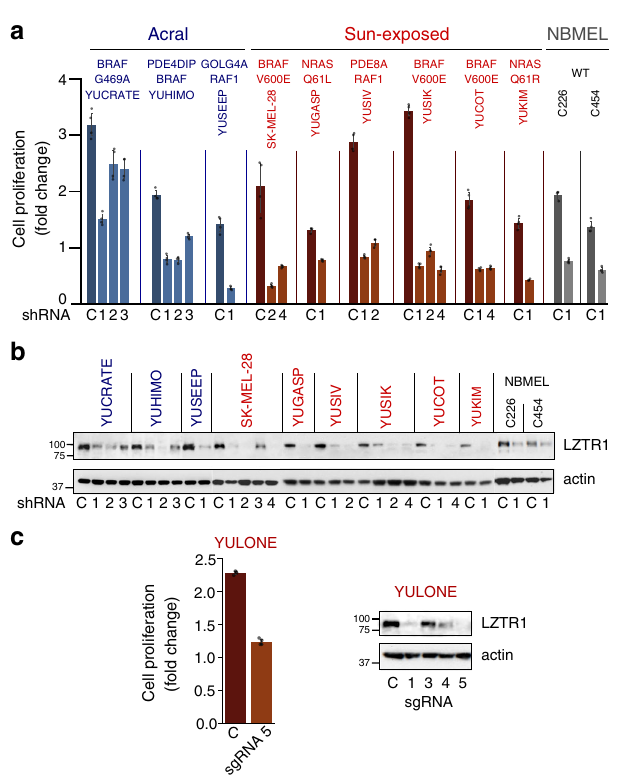
Fig. 3 Cell proliferation in response to the suppression of LZTR1. a Impact of LZTR1 knockdown on cell proliferation in nine primary melanoma cell lines and two normal human melanocyte lines (NBMEL). Key mutations are indicated (Supplementary Table 7). Bar plots depict mean fold change between the 3rd and 6th day after infection with LZTR1 shRNA (numbered), as compared to control (scrambled) shRNA (C) with error bars indicating 95% con fi dence intervals. b Western blots with anti-LZTR1 antibodies showing the ef fi cacy of LZTR1 knockdown, related to panel a . This experiment was reproduced twice with LZTR1 shRNA 1 and shRNA 2, compared to control. c Cell proliferation (left) and LZTR1 expression (right) of a sun-exposed melanoma cell line that lost one LZTR1 allele in response to genomic modi fi cation by different CRISPR-Cas9 sgRNAs targeting LZTR1 . Bar plots depict fold change between the 3rd and 6th day after infection with sgRNA 5. Data represent one experiment. Bars in a , c represent the mean of triplicate wells with error bars indicating 95% con fi dence intervals. Actin levels in b and c show protein loading. Cell lines are indicated above all plots in a – c and colored according to their origin: acral melanoma (blue), sun-exposed melanoma (red), normal melanocyte (gray). NBMEL newborn melanocytes, WT wildtype. Source data are provided as a Source Data fi